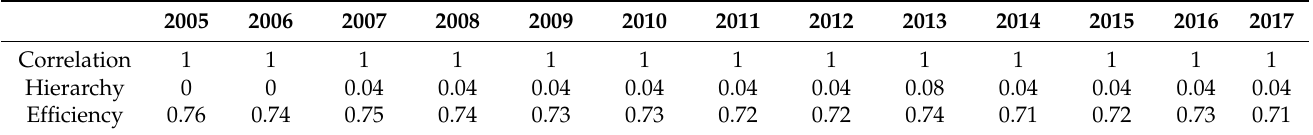
Table 3. Network features of